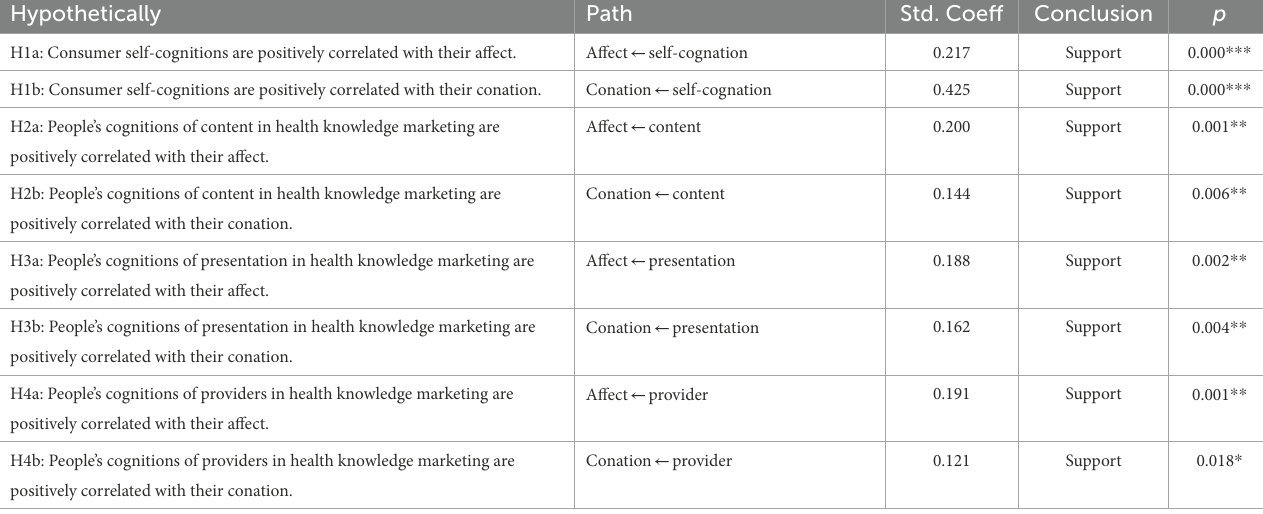
TABLE 11 Results of hypothesis testing.